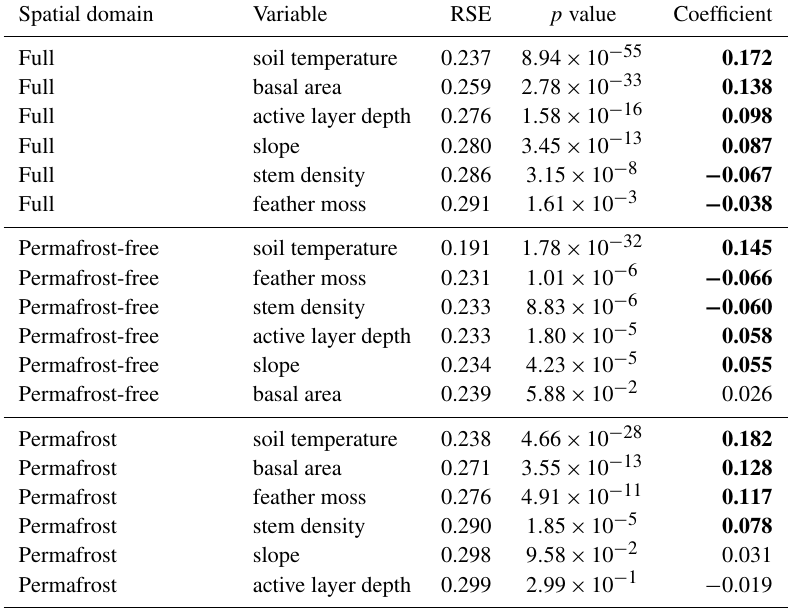
Table 4. Generalized least squares model fits for soil respiration across both seasons. The same soil collars were sampled in both seasons so spatial structure could not be introduced into the models. All other details as in Table